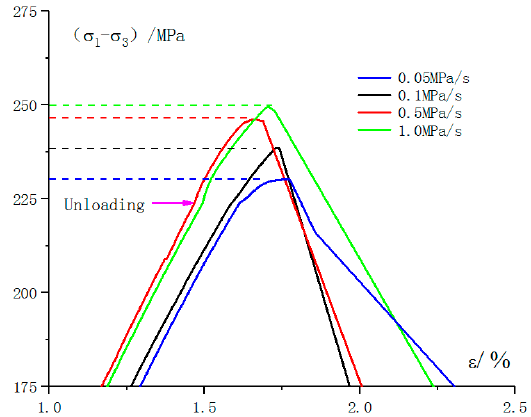
Figure 16. Magnification of typical stress–strain curves for four unloading rates.